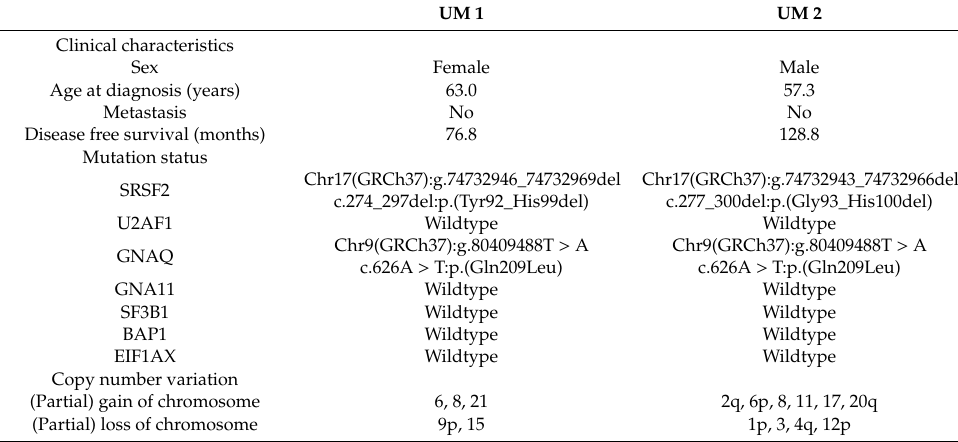
Table 1. Overview of clinical characteristics, mutation status and copy number variation of uveal melanoma (UM) patients with an SRSF2 mutation.